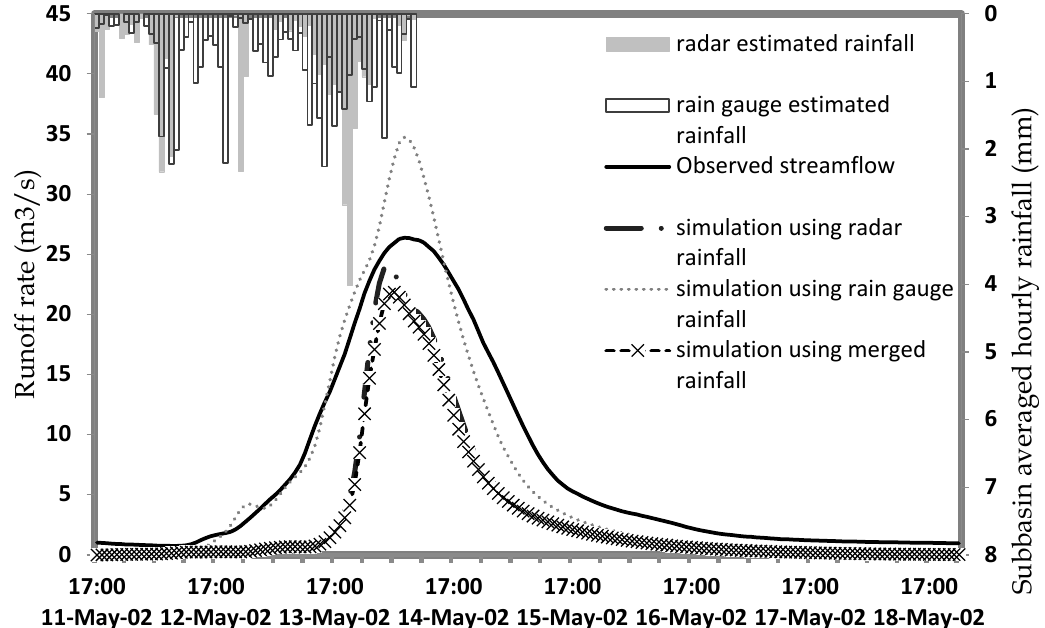
Figure 13. Comparison of estimated and observed hydrographs using different rainfall estimates for the 21 May 2001 event with SCS modeling option.